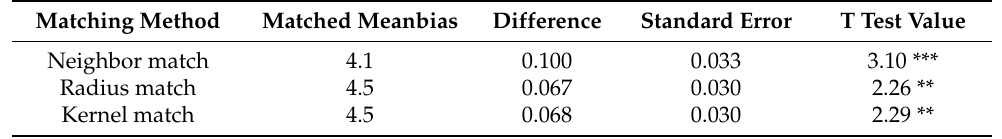
Table 9. Estimated results of